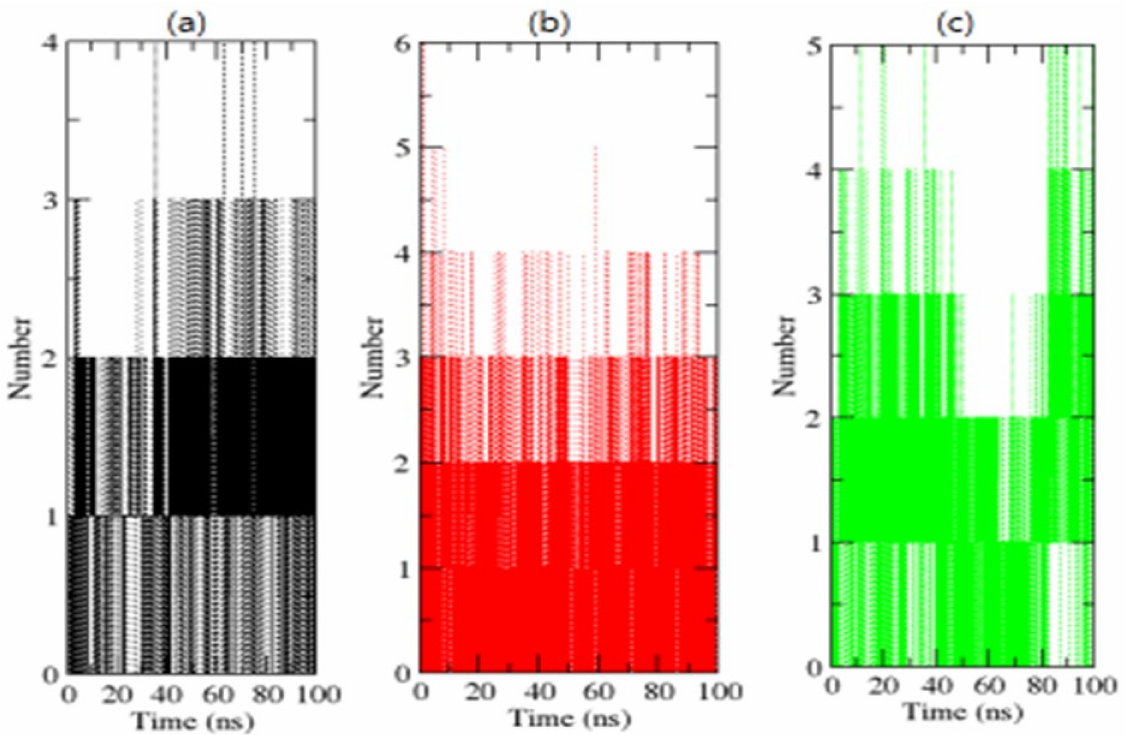
Figure 8. H-bond analysis of complexes. The OmpU-control compound, OmpU-ZINC95910434, and OmpU-ZINC06494587 are shown in black, red, and green color,